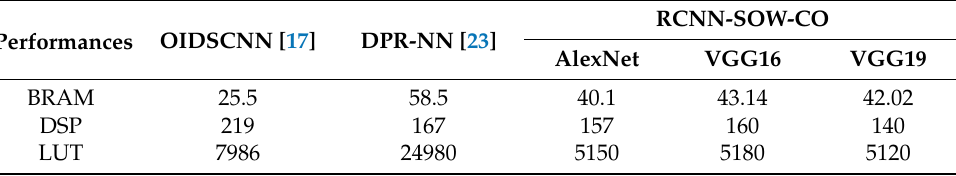
Table 11. Comparative analysis of RCNN-SOW-CO architecture for